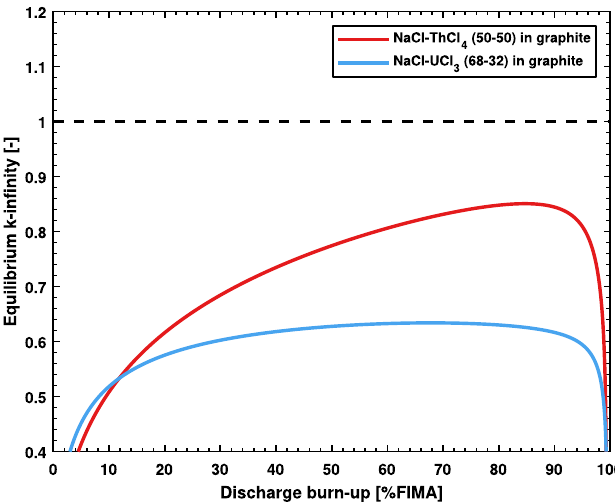
Fig. 7. Evaluation of the k ∞ at equilibrium of chloride salts in a thermal spectrum using the neutron excess method.